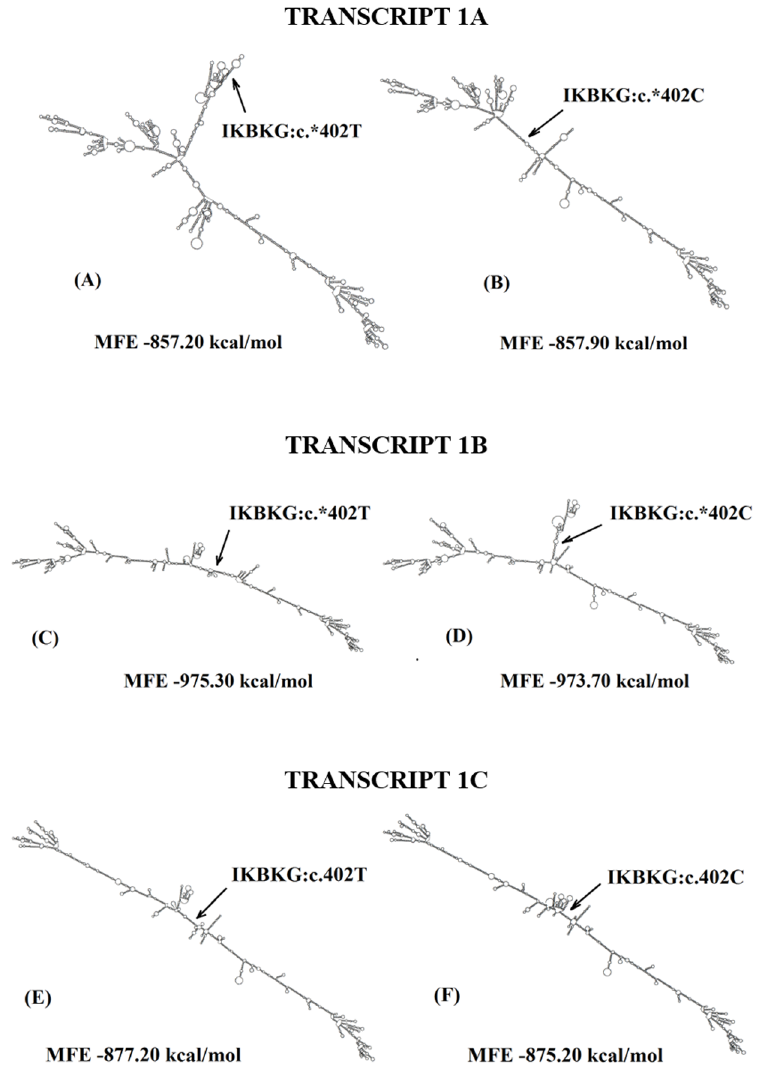
Fig 1. The influence of IKBKG:c. * 402C/T variation on the secondary structure of 1A, 1B and 1C transcripts. Analysis was conductedusing RNAfold software. (A) transcript 1A with 402T variant; (B) transcript 1A with 402C variant; (C) transcript 1B with 402T variant; (D) transcript 1B 402C variant; (E) transcript 1C with 402T variant; (F) transcript 1C with 402C variant. MFE—Minimum Free